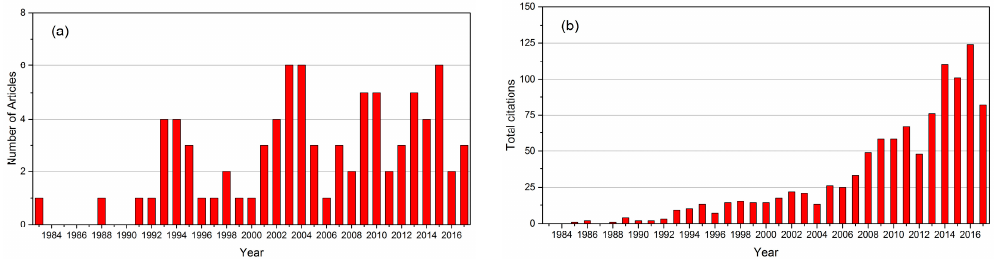
Figure 2. Literature statistics for BRDF modeling over rugged terrain from 1983 to 2017. ( a ) The numbers of published articles, and ( b ) total citations.